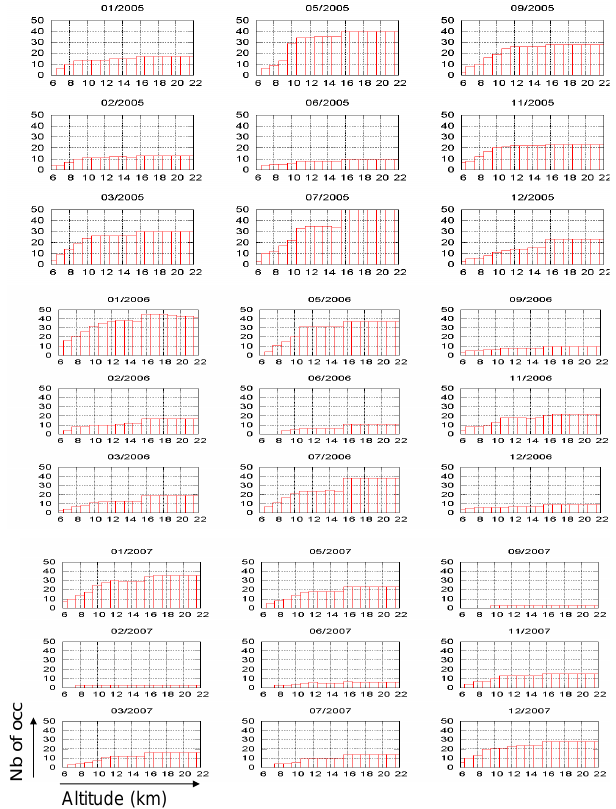
Fig. 3. Number of ACE-FTS occultations (y-axis) available for the 50 ◦ N–60 ◦ N latitude band for nine months of the years 2005 to 2007 (April, August and September are not covered for this latitude band) and for each altitude (x-axis, unit: